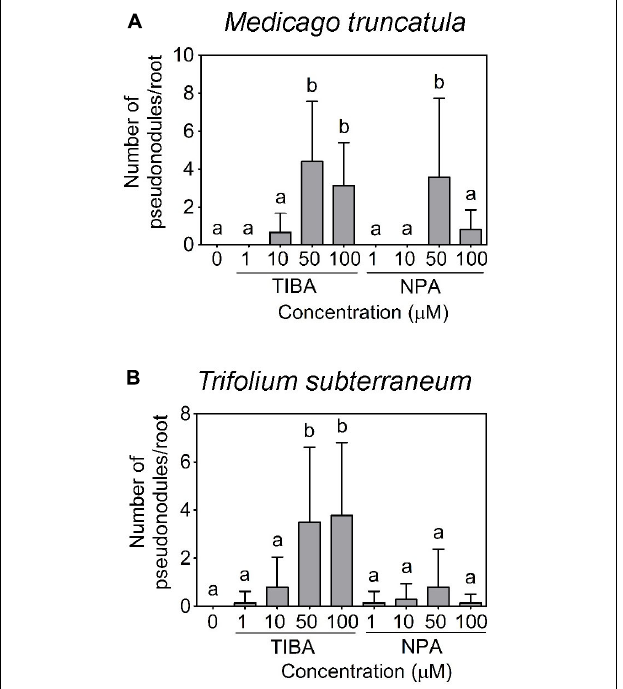
FIGURE 4 | Pseudonodule formation in response to TIBA and NPA treatment at various concentrations. Pseudonodule formation on the roots of (A) M. truncatula and (B) Trifolium subterraneum (subclover), in response to TIBA and NPA treatments within the concentration range of 0–100 µ M. A two-way ANOVA with a Dunn’s multiple comparison post-test were used for statistical analyses. Different lowercase letters indicate statistically different number of pseudonodules per root ( p < 0.05, n = 20–25 per treatment). Graphs show mean and SD. Abbreviations: TIBA, 2,3,5-triiodobenzoic acid and NPA, 1- N -naphthylphthalamic